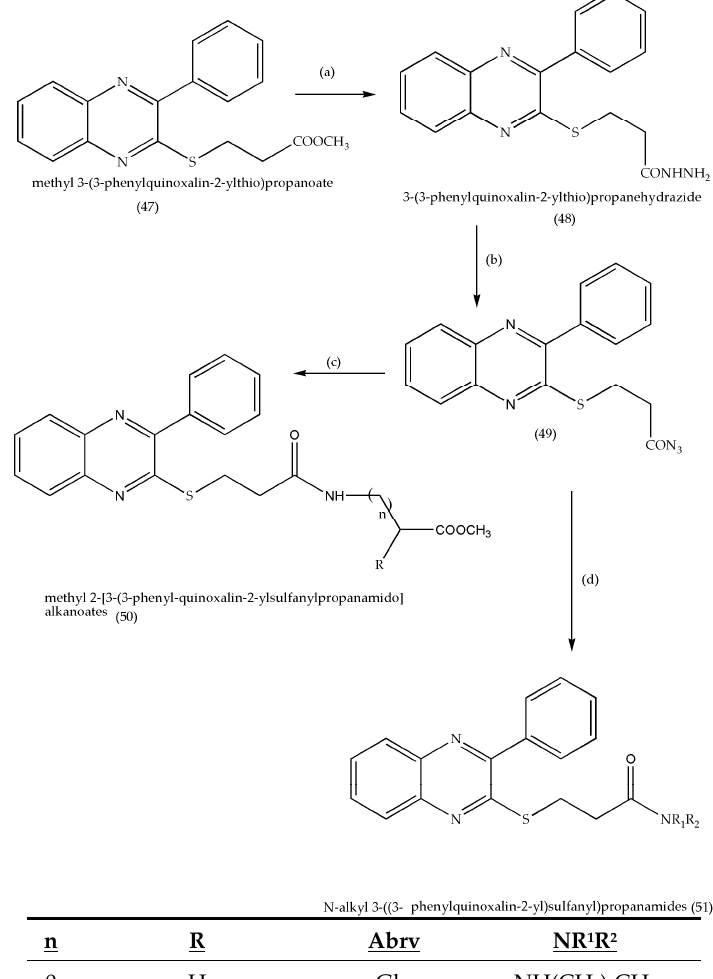
Scheme 14. Synthetic pathway to prepare S-alkylation of phenyl quinoxaline-2(1 H )-thione ( 47 ) with